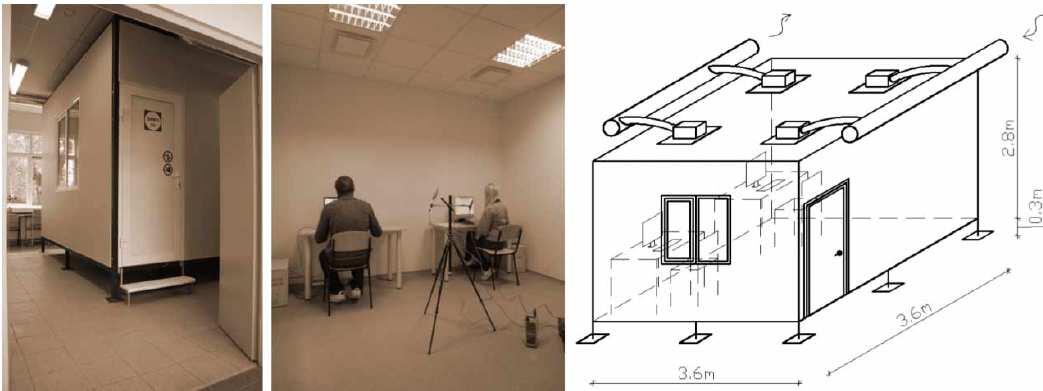
Fig. 2. View and geometry of the test chamber used in the study